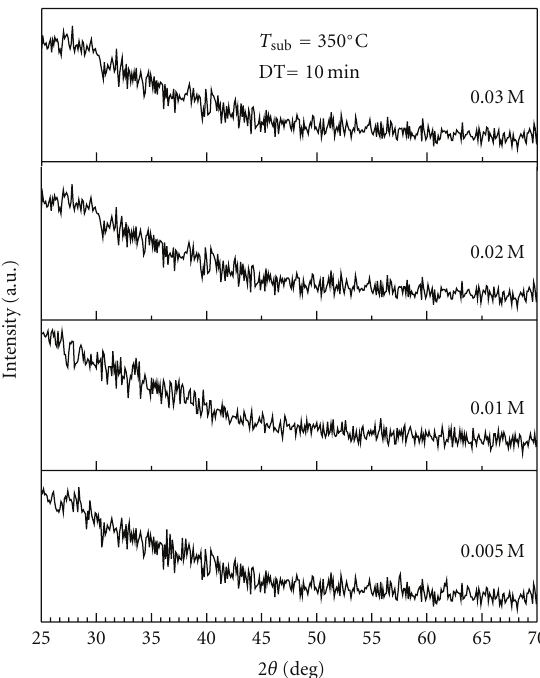
Figure 3: X-ray di ff raction patterns for IrO 2 films as a function of solution molarity at T sub = 450 ◦ C and deposition time = 10